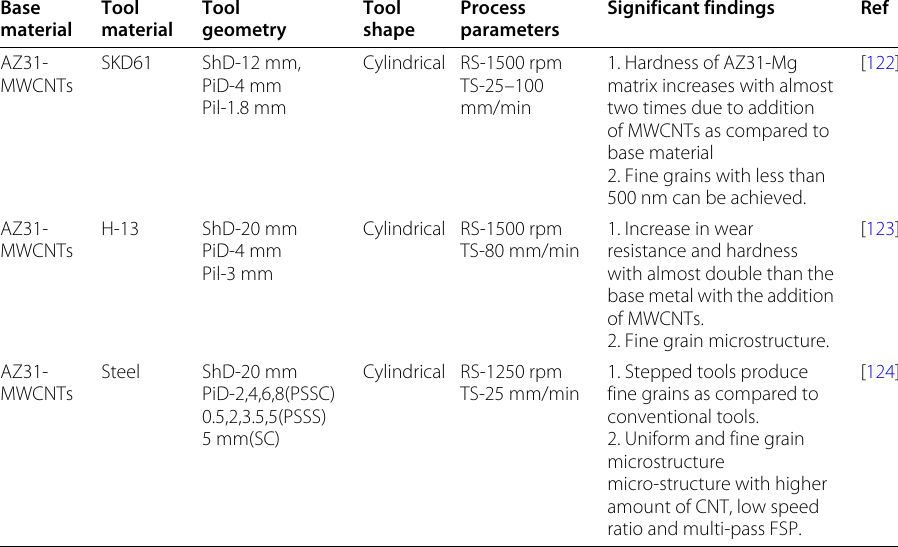
Table 5 Brief summary of Mg-MWCNTs surface MMCs by FSP as available in the literature Base